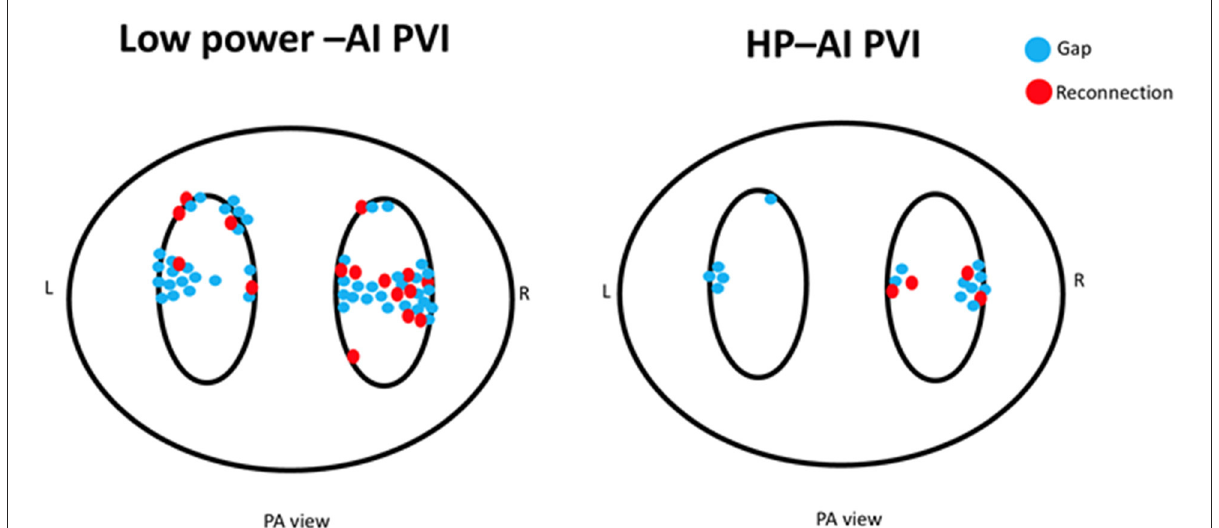
FIGURE2 The distribution of additional lesions for closing gaps for acute PVI (blue dots) and reconnected sites for the two groups (red dots). Of note, the low power-AI group required more ablation sites to achieve PVI. The distribution of gaps and reconnections was mainly located in the carinal area between the superior and inferior veins.